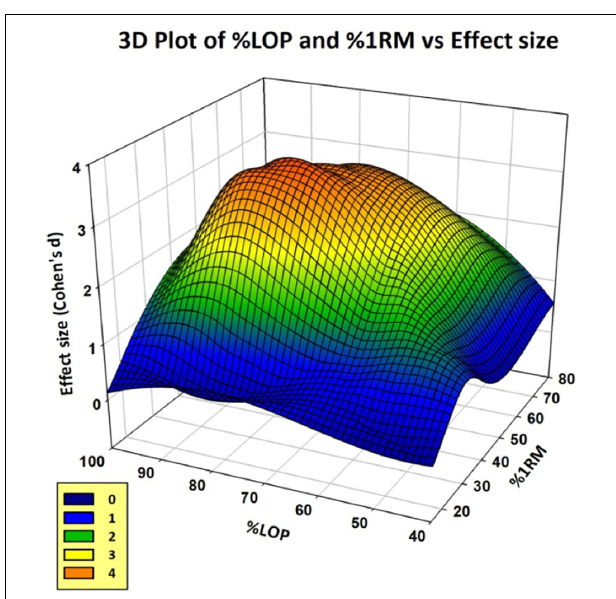
FIGURE 5 | 3D plot of %LOP ( x -axis), %1RM ( y -axis), and Effect Size ( z -axis) for the 48